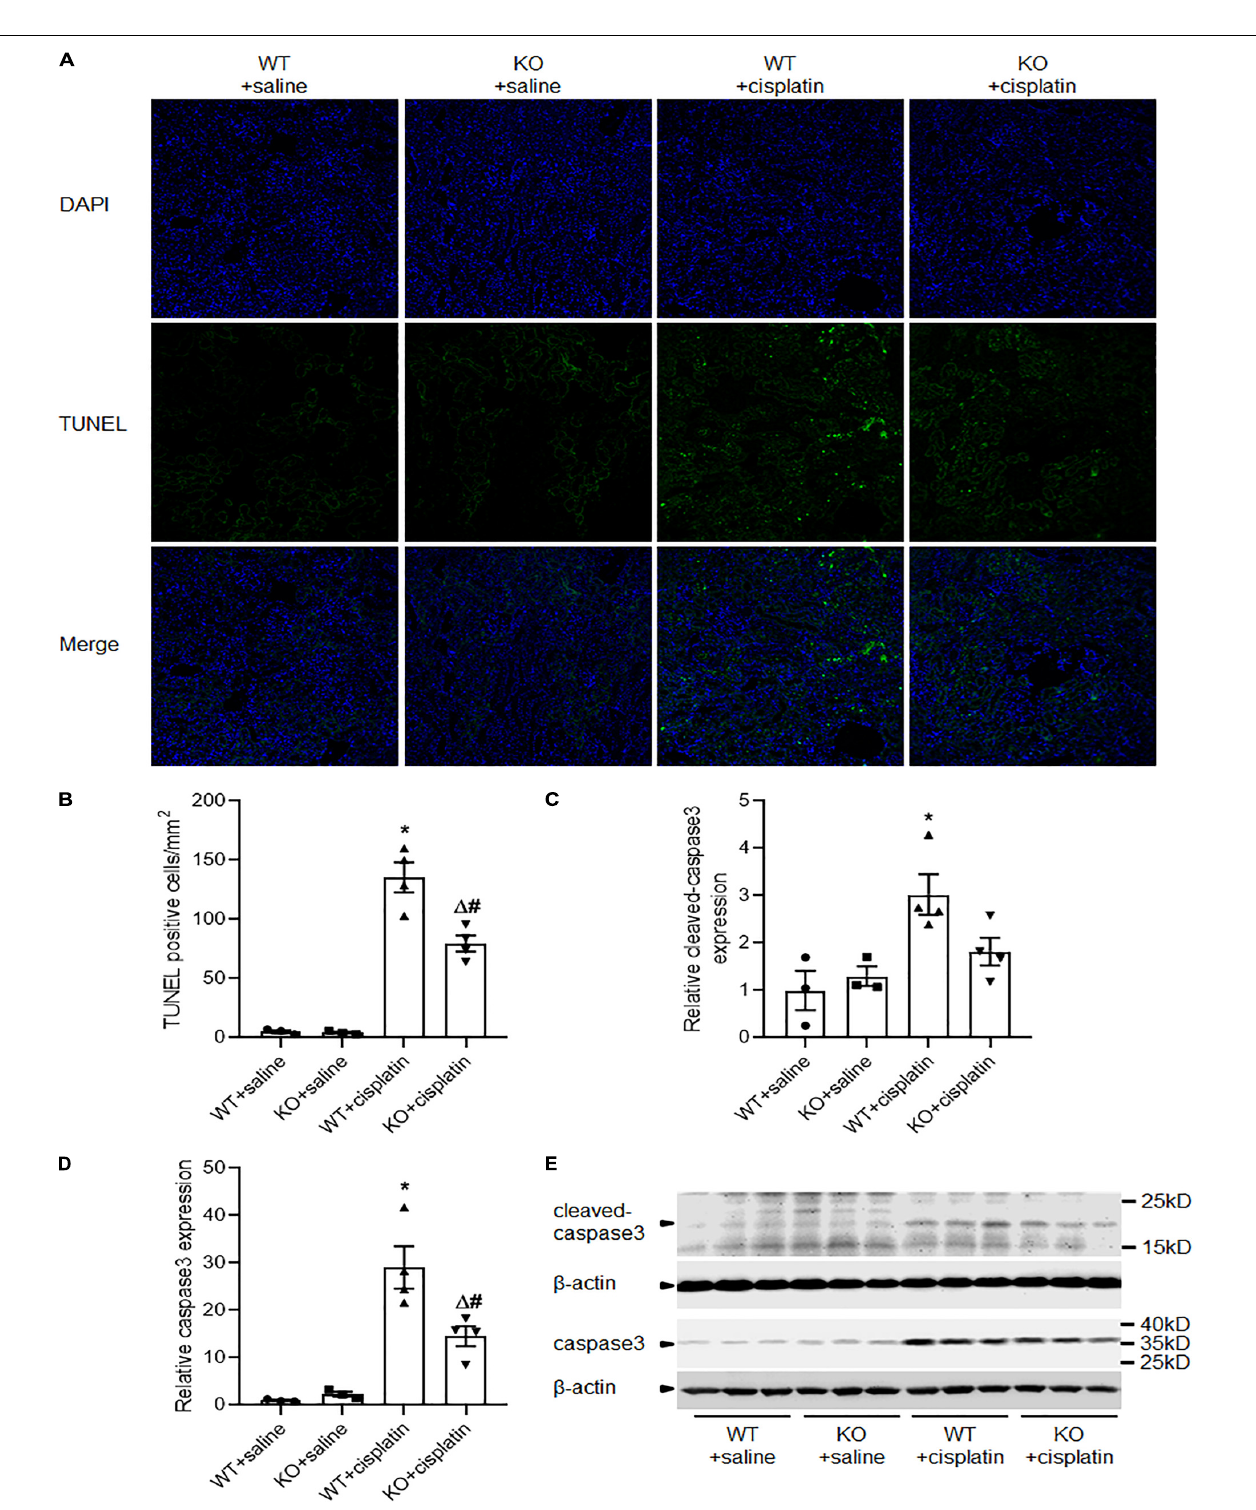
FIGURE 5 | PINK1 deficiency attenuated cisplatin-induced renal tubular cell apoptosis. (A) Presented are the representative photographs of TUNEL staining of kidney tissues in PINK1 WT and KO rats after cisplatin treatment. (B) Quantitative analysis of TUNEL-positive cells among the various groups. (C,D) Quantitative analysis of the western blotting of cleaved caspase3 and caspase3. (E) Representative western blot bands of cleaved caspase3 and caspase3. N = 3 in WT + saline group and KO + saline group, N = 4 in WT + cisplatin group and KO + cisplatin group. ∗ P < 0.05, WT + cisplatin vs. WT + saline; # P < 0.05, KO + cisplatin vs. WT + cisplatin; (cid:49) P < 0.05, KO + cisplatin vs. KO + saline; $ P < 0.05, KO + saline vs. WT + saline. Data are mean ± SE.